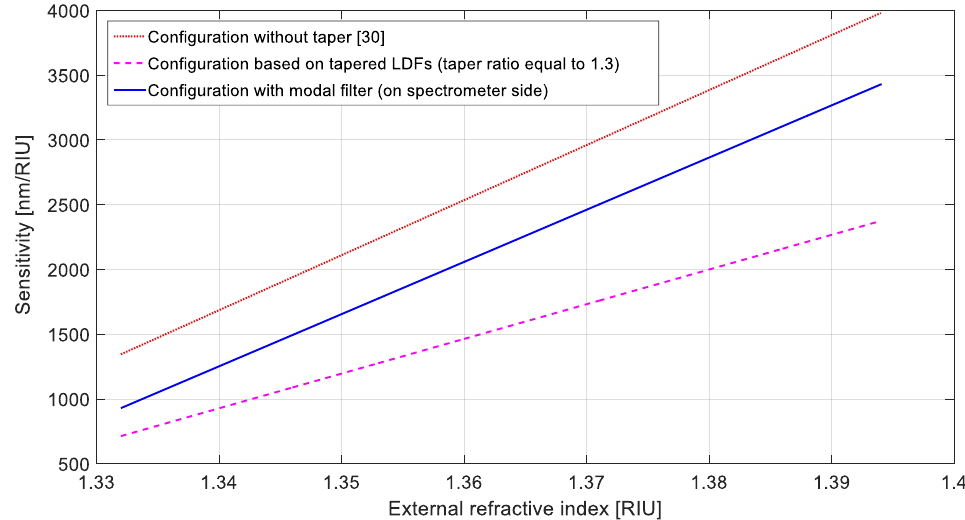
Figure 6. Sensitivity as a function of the refractive index for all the configurations based on silica LDF without a taper (red dots), silica LDF with a taper ratio equal to 1.3 (magenta dashes), and with a silica LDF as a modal filter on the spectrometer side (blue line).